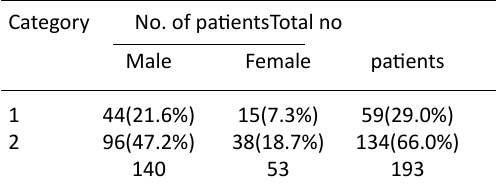
Table 2. Category wise